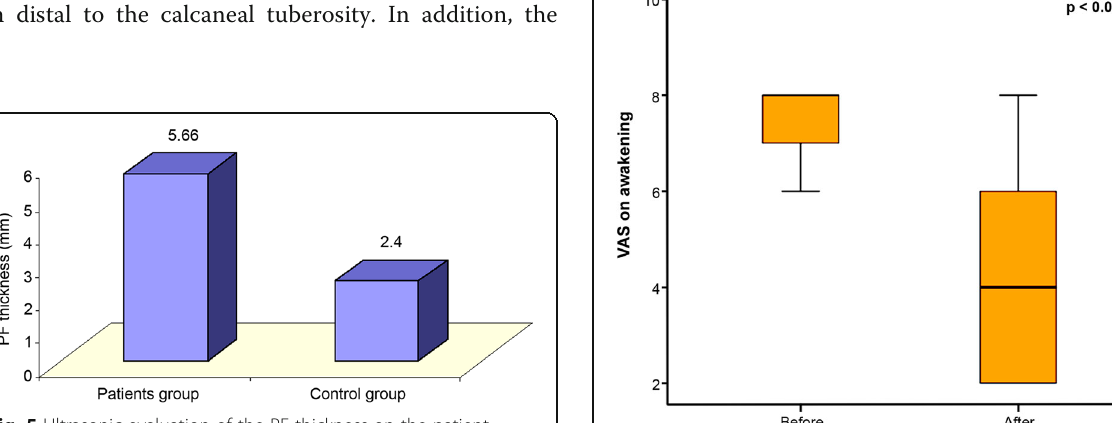
Fig. 5 Ultrasonic evaluation of the PF thickness on the patient group before and after ESWT